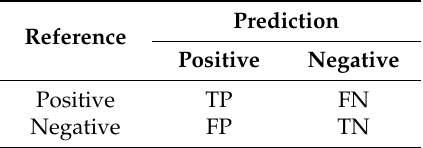
Table 1. Confusion matrix